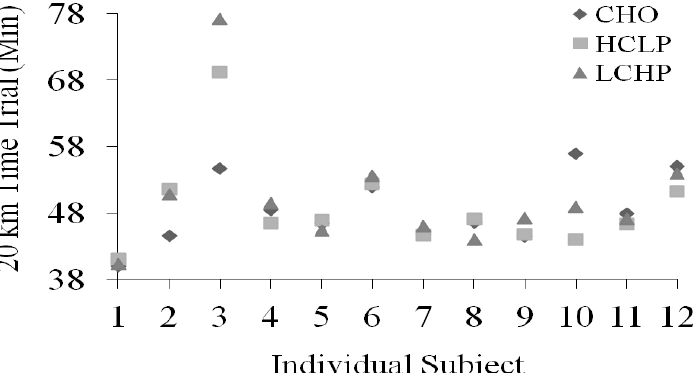
Figure 2. Individual Performance Times during EX2